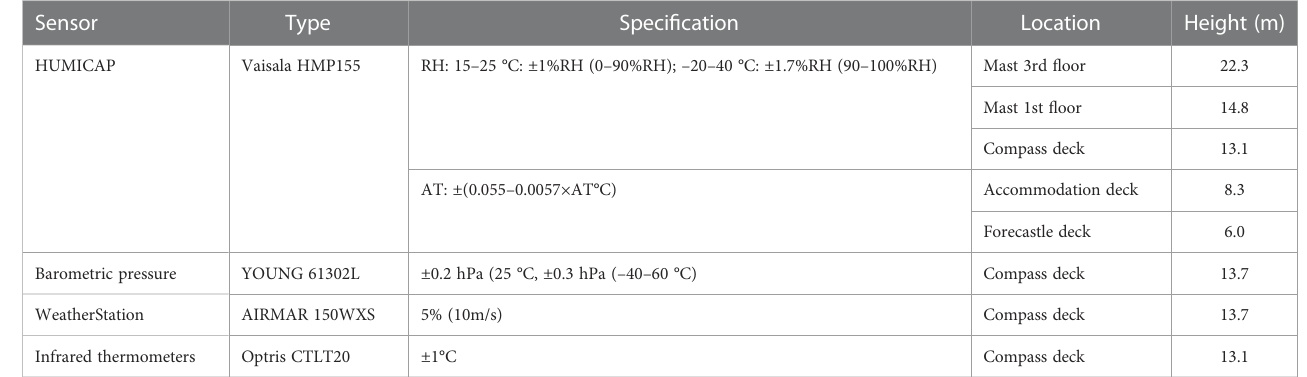
TABLE 1 Sensor parameters and installation location